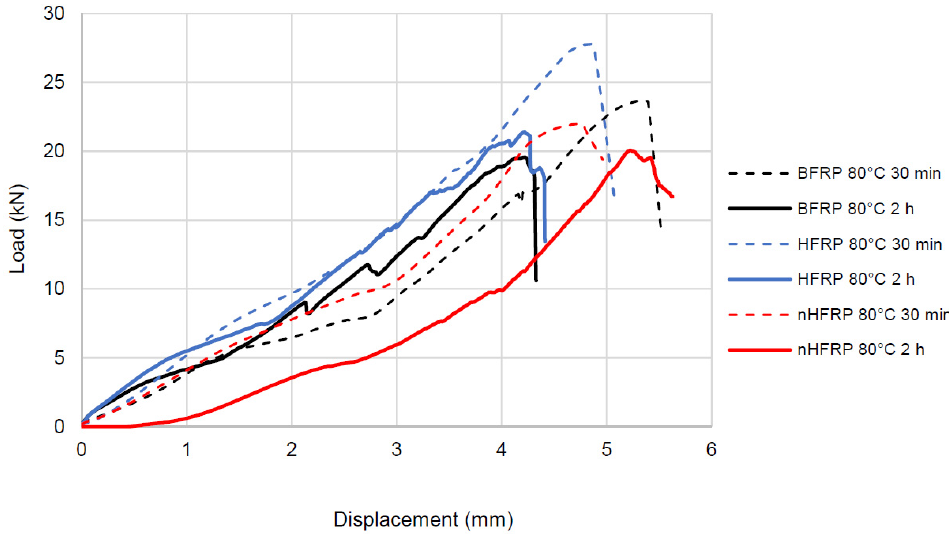
Figure 8. Scheme of the dependence of the shear force on the shear displacement of the press actuator for sample no. 1, diameter 8 from each type of bar: BFRP, HFRP, and